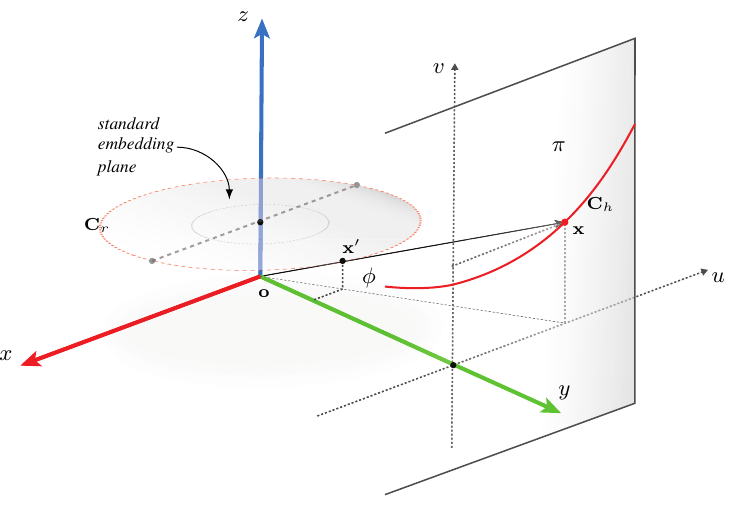
Figure 3. Projectivity between points on the standard embedding plane and points on a projective conic in an embedding plane π